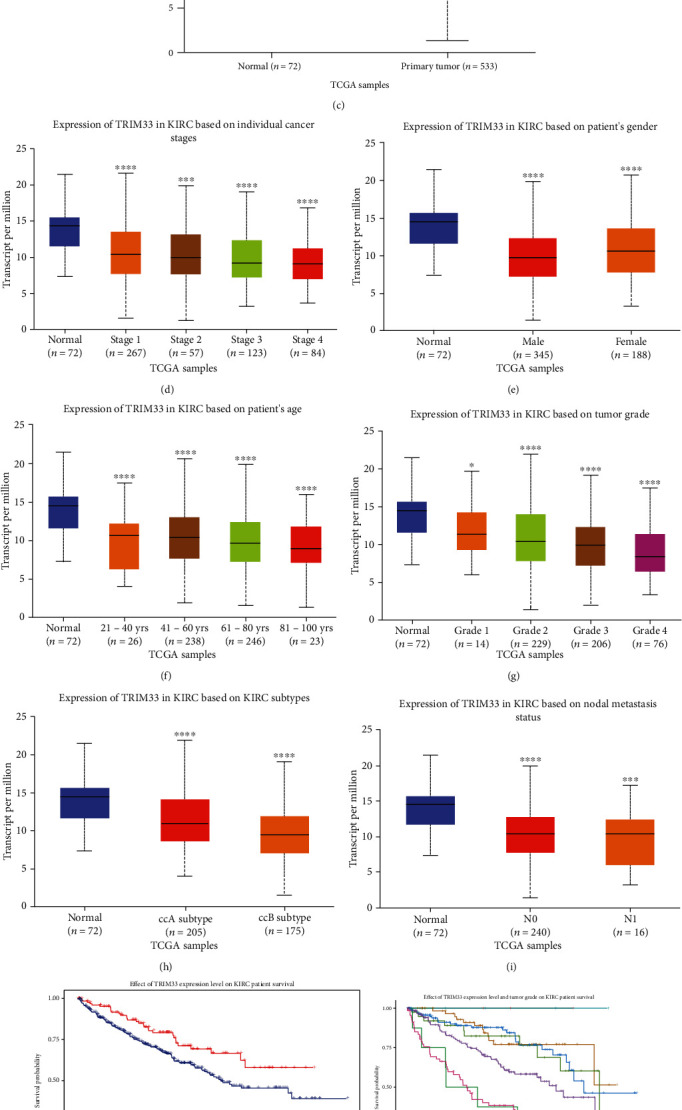
TRIM33 is downregulated in various tumors and is related to the progress of ccRCC. (a and b) TRIM33 expression in pan-cancer; red represents tumor tissue and blue represents normal tissue. (c) Analysis of differences in TRIM33 mRNA levels between ccRCC tissues and normal tissues through the UALCAN website based on TCGA. (d–i) The difference in expression of TRIM33 according to individual cancer stages, patient's gender, patient's age, tumor grade, KIRC subtypes, and nodal metastasis status. (j) Relationship between TRIM33 expression and survival of renal cell carcinoma patients. (k) KM plot depicting the association of TRIM33 expression levels and tumor grade with patient survival. (l) KM plot depicting the association of TRIM33 expression levels and gender with patient survival. (m and n) The relationship between the expression of TRIM33 in ccRCC and the survival of patients through the HPA website. ∗P < 0.05; ∗∗P < 0.01; ∗∗∗P < 0.001; ∗∗∗∗P < 0.0001.